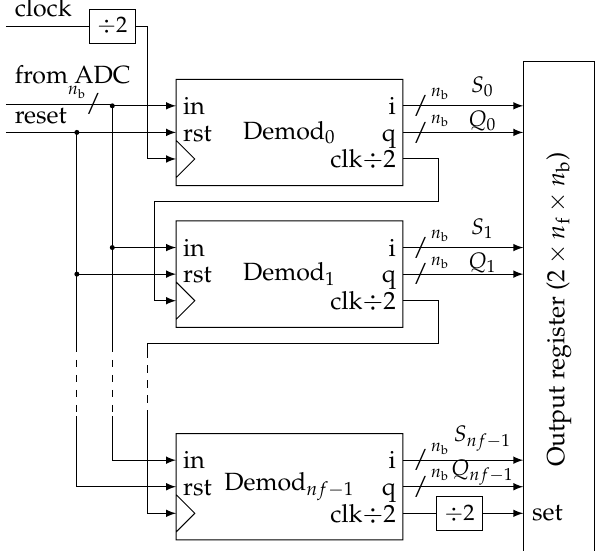
Figure 7. Overview of the parallel implementation of the impedance estimation